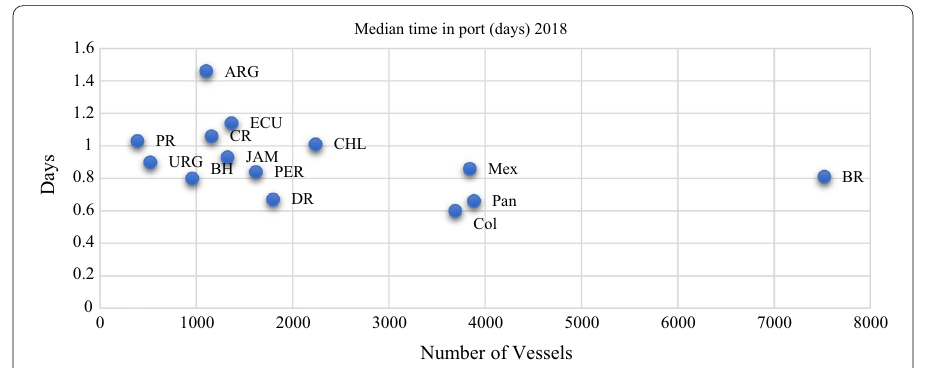
Fig. 1 Median time (days) and number of vessels (No.) for leading container ports (country) within LAC. Source : World Bank